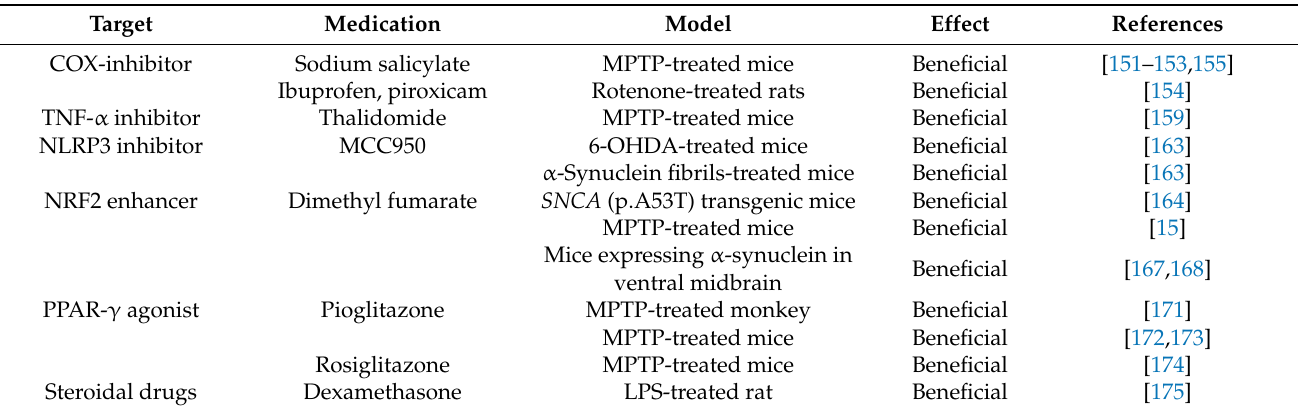
Table 2. Therapeutic target of neuroinflammation in